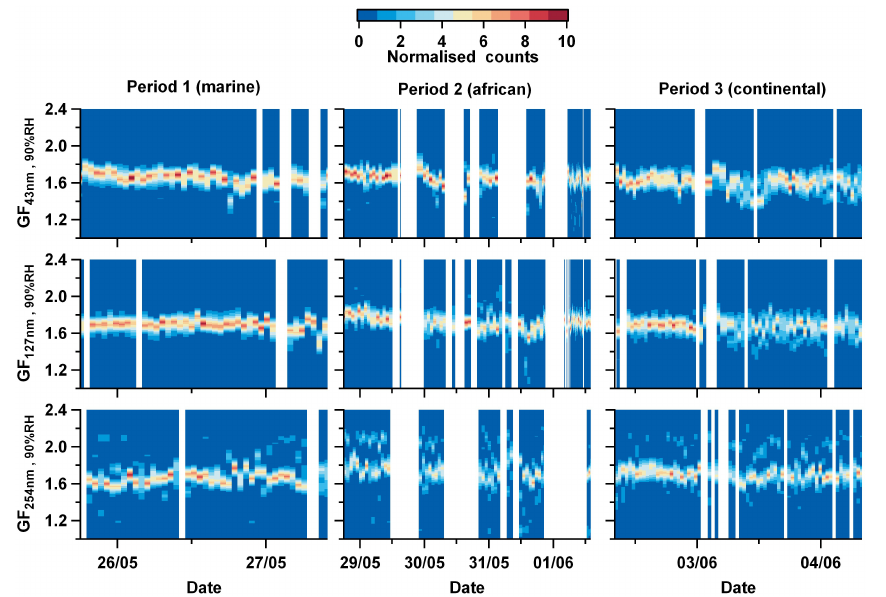
Fig. 4. The retrieved growth factor probability density distributions for the 3 study periods at 90%RH for D 0 s of 43, 127 and 254nm. White gaps indicate periods when the HTDMA was performing humidograms or was being calibrated.